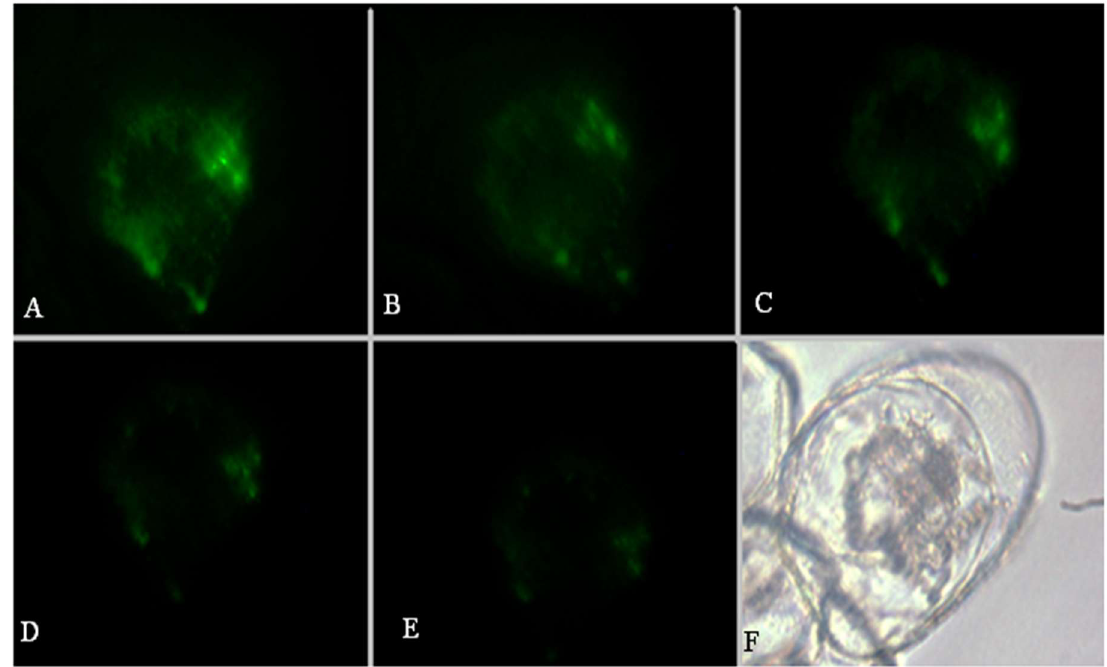
Figure 2. A series of images of cells were undergoing disruption of respiratory electron transport chains after treating 1 mmol/L of OA. Rd123 stained the cells. The green fluorescence of Rd123 in the mitochondria was evident ( A ). After the treatment of 1 mM OA, the fluorescence intensity began to decrease after 15 min ( B ). The boundary became obscure, and the fluorescence intensity continued to drop after 30 min ( C ). After 60 min the fluorescence intensity in the mitochondria decreased markedly ( D ). The fluorescence intensity disappeared almost entirely after 75 min ( E ). The bright-field photo of ( E ) picture ( F ).